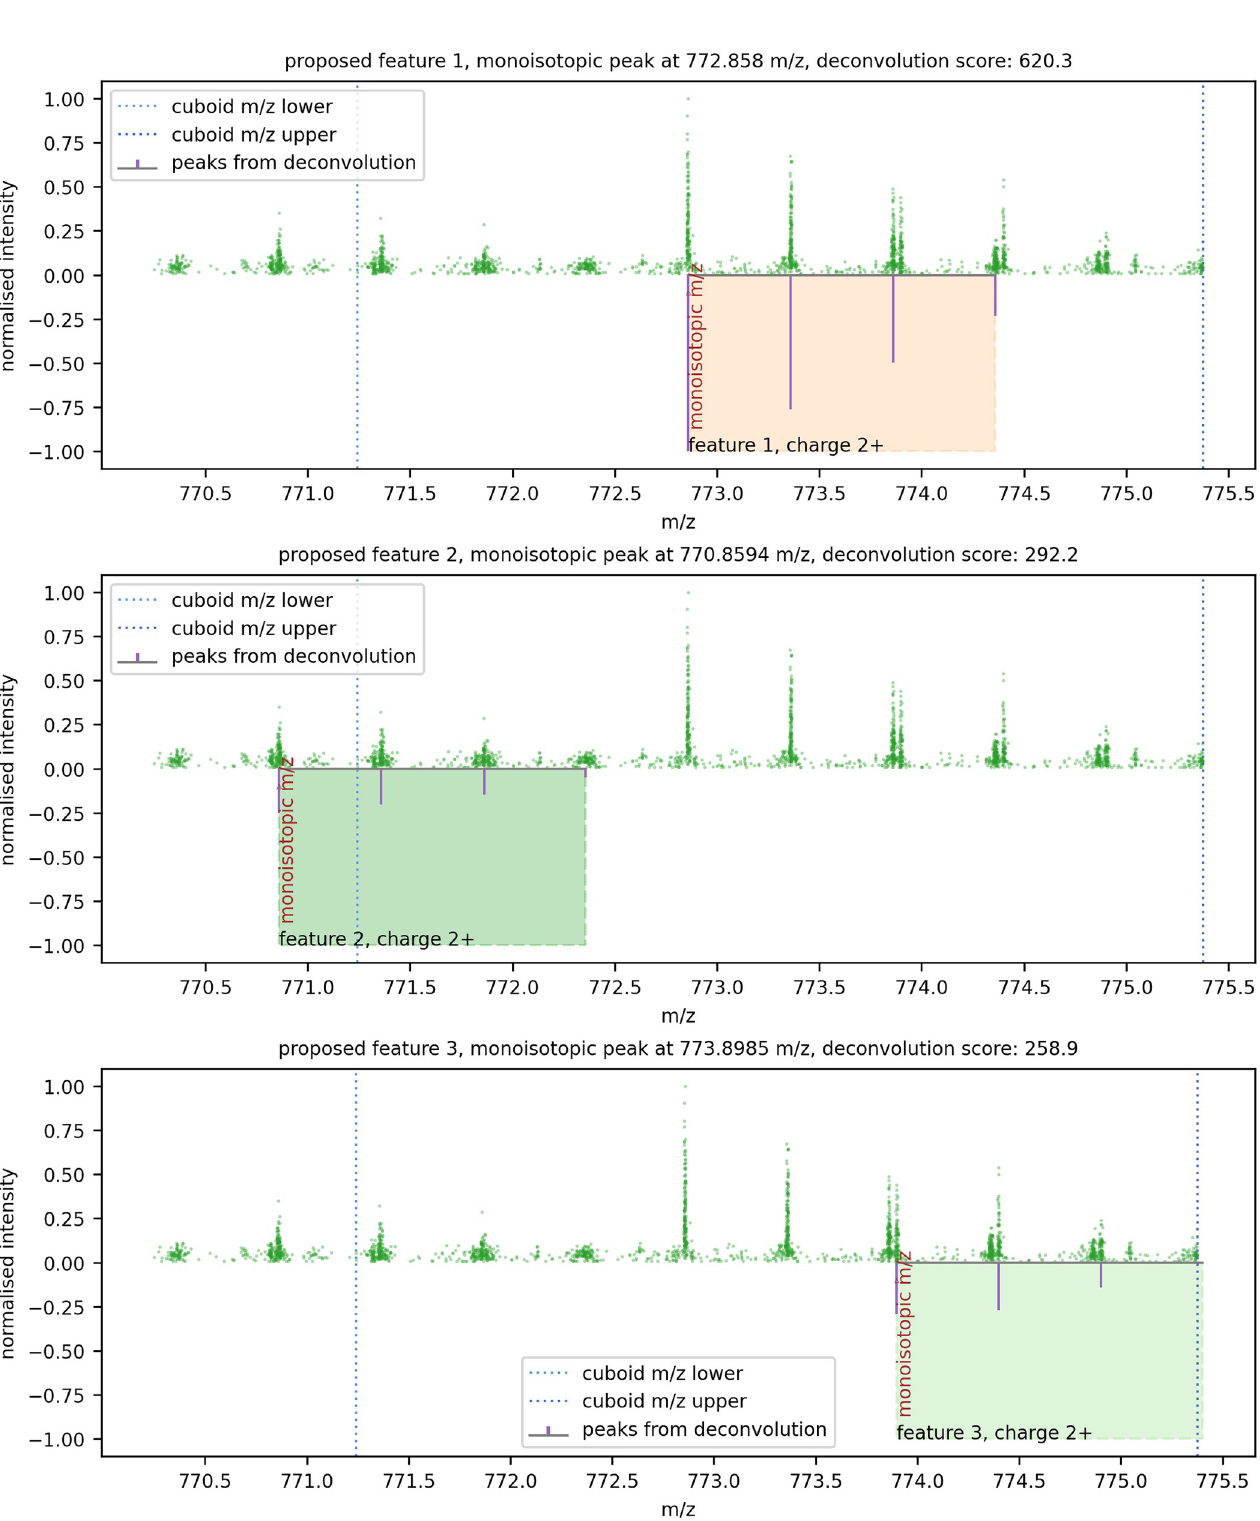
Fig 4. A set of proposed features derived from the simplified spectra for a precursor cuboid.